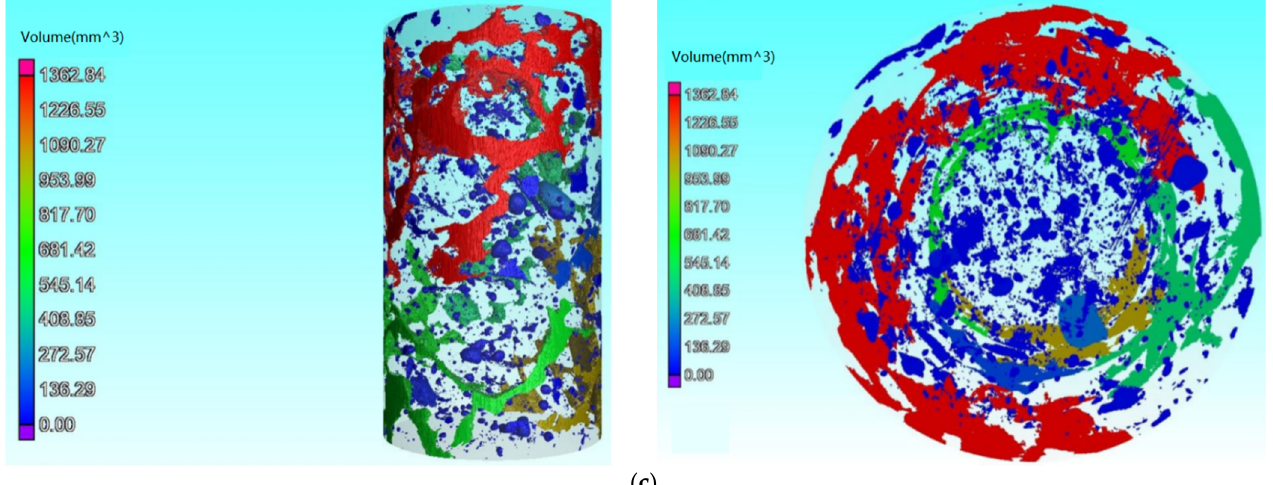
Figure 12. Three-dimensional pore distribution in the concrete specimen. ( a ) Pore distribution in the concrete specimen in its original state. ( b ) Pore distribution in the concrete specimen after the first circle. ( c ) Pore distribution in the concrete specimen after the second circle.